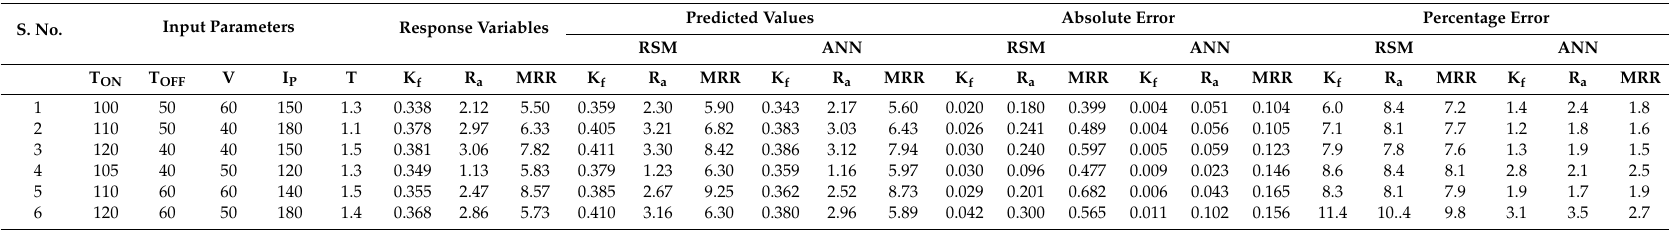
Table 9. Comparison of predicted WEDM output parameters by RSM and ANN with experimental results, including absolute and percent errors. S.